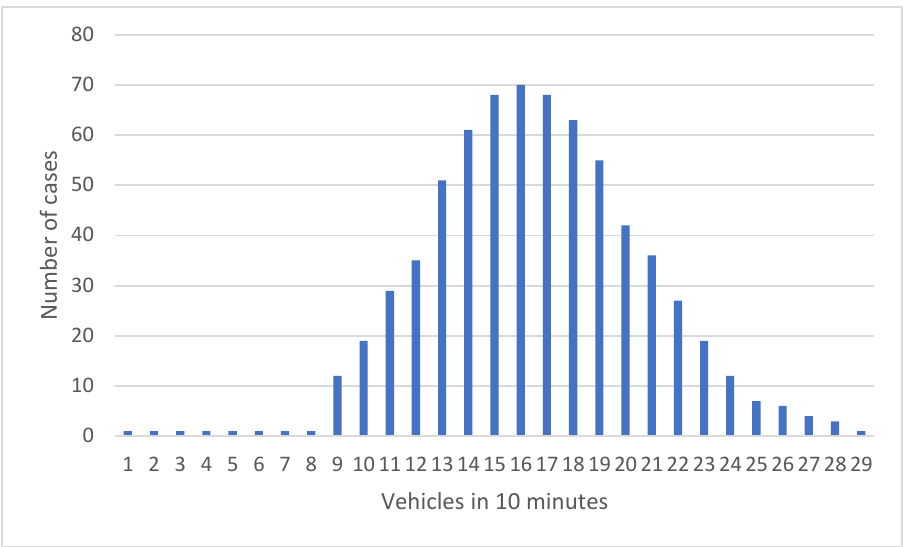
Figure 9. The empirical collected data.